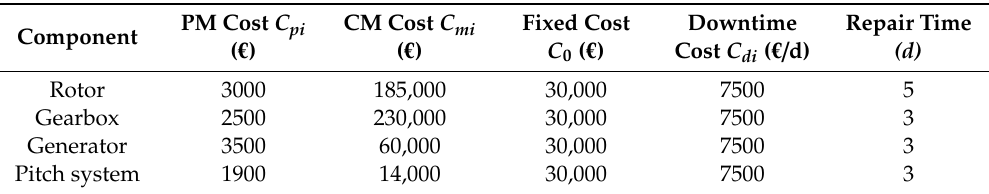
Table 1. Maintenance cost information for each component.